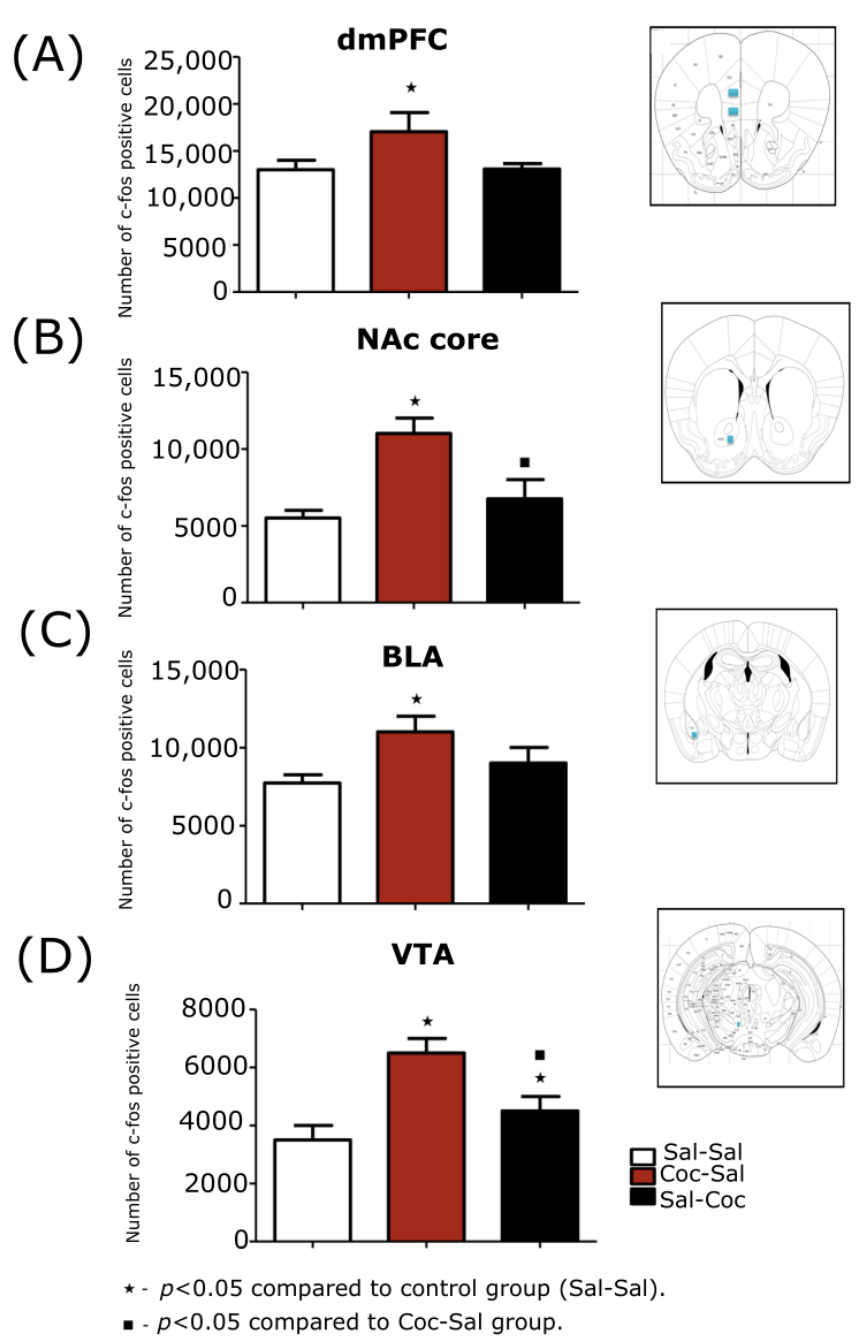
Figure 3. Stereological analysis of the expression c-Fos protein in animals treated with cocaine, administered in a paired way (Coc-Sal) or not (Sal-Coc) to the environmental context in the induction phase in the following structures: ( A ) The dorsomedial prefrontal cortex (dmPFC) measurements were performed at 1.95 mm of bregma, a representative area of quantification is observed by the blue rectangles on the right. ( B ) The nucleus accumbens core (NAc core) measurements were performed at 1.18 mm of bregma, a representative area of quantification is observed by the blue rectangle on the right. ( C ) The basolateral amygdala (BLA) measurements were performed at − 1.22 mm of bregma, a representative area of quantification is observed by the blue rectangle on the right. ( D ) The ventral tegmental area (VTA) measurements were performed at − 2.92 mm of bregma, a representative area of quantification is observed by the blue rectangle on the right. The number of c-Fos positive cells is expressed as mean ± SEM. The one-way ANOVA test was performed, followed by the Duncan post hoc